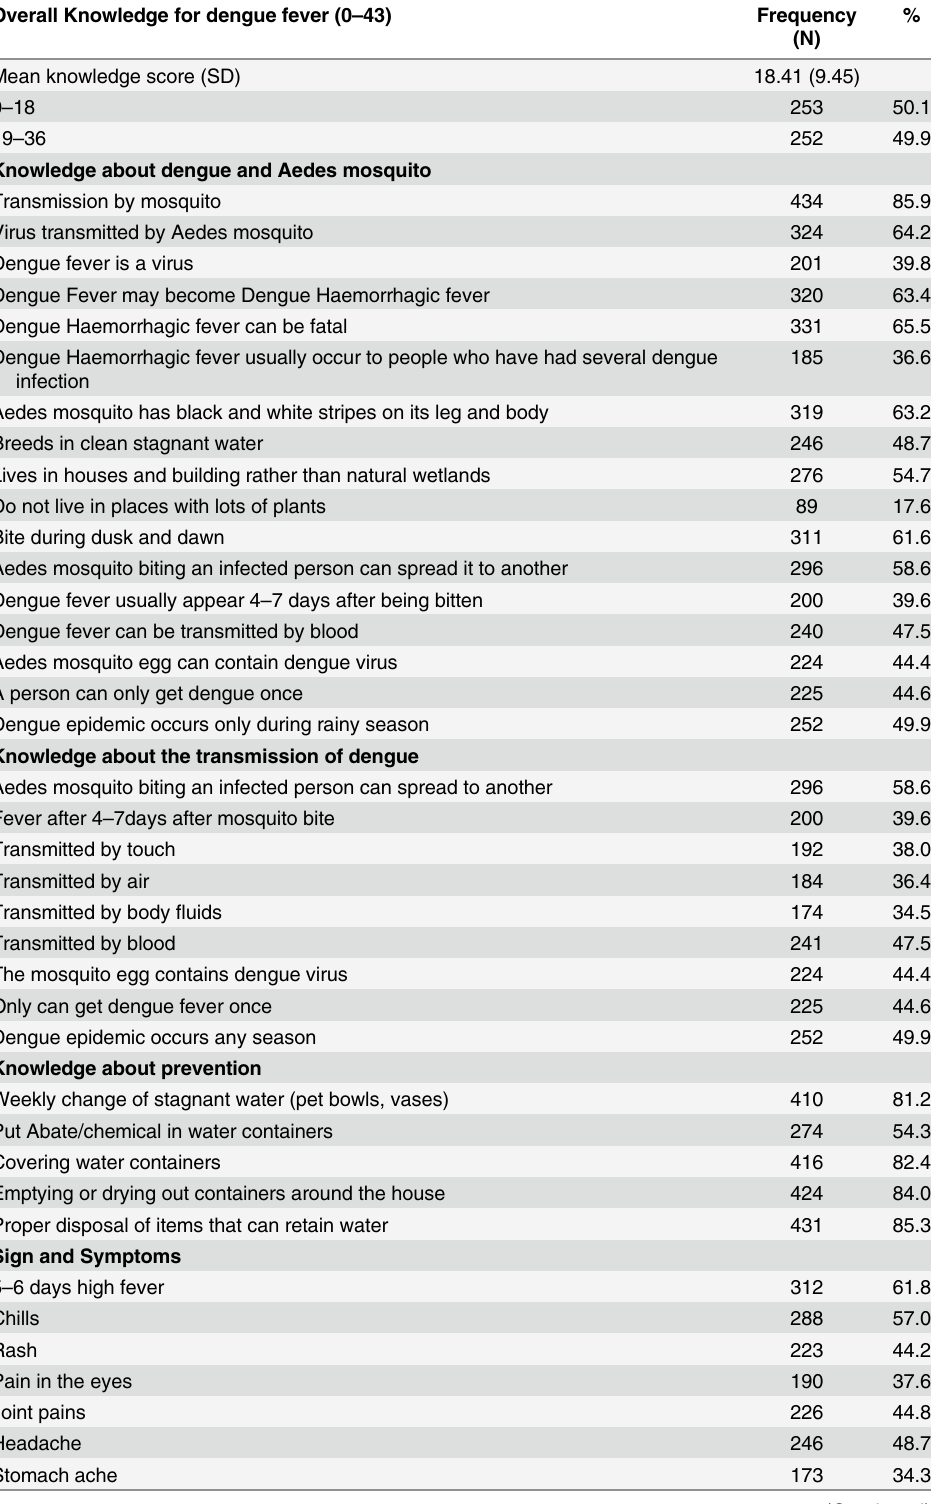
Table 2. Overall knowledge about dengue fever (correct